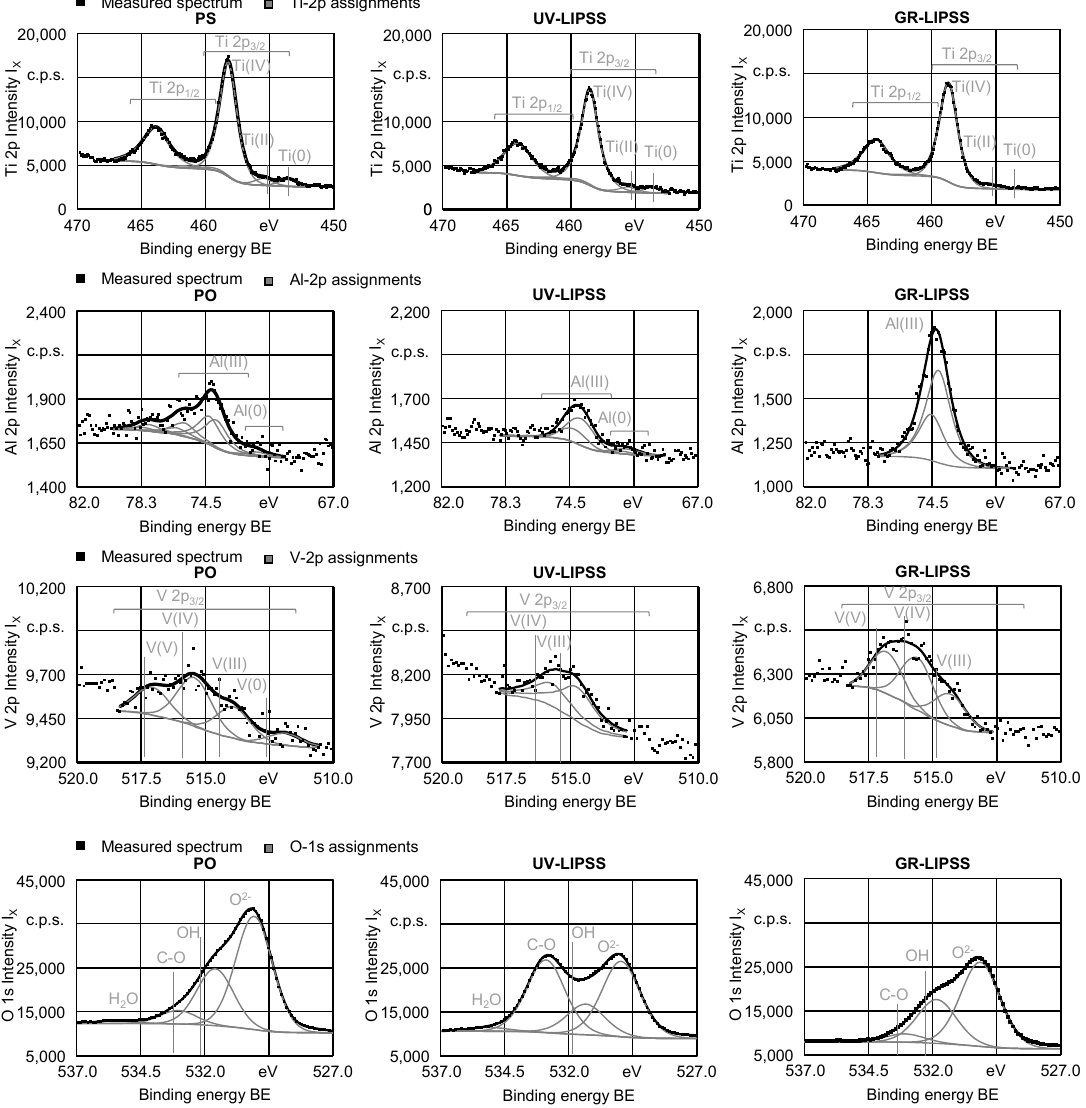
Figure 3. X-Ray photoelectron spectra for regions Ti 2p, Al 2p, V 2p 3 / 2 , and O 1s of PO, UV-LIPSS and GR-LIPSS.